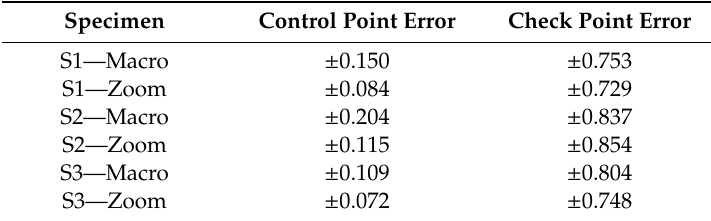
Table 4. Results for the bundle adjustment for the pre-calibrated configurations.